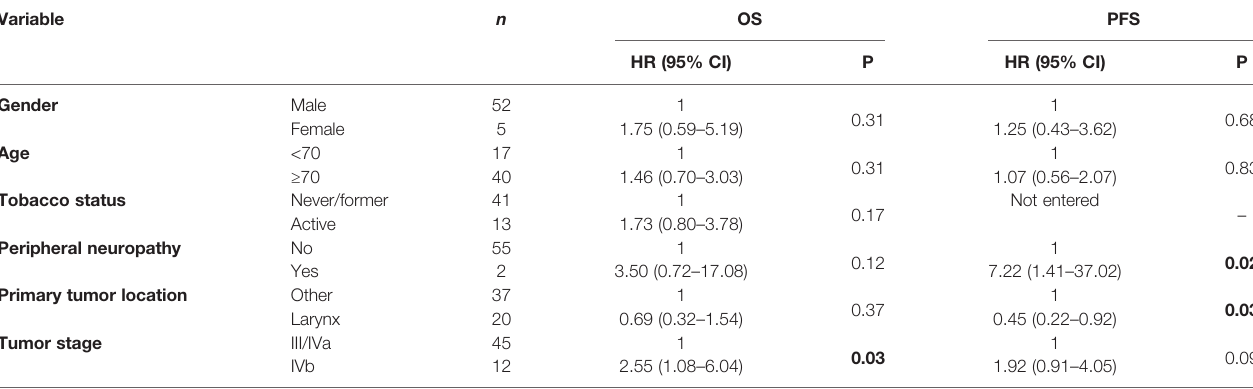
TABLE 4 | Multivariate Cox regression analysis for OS and